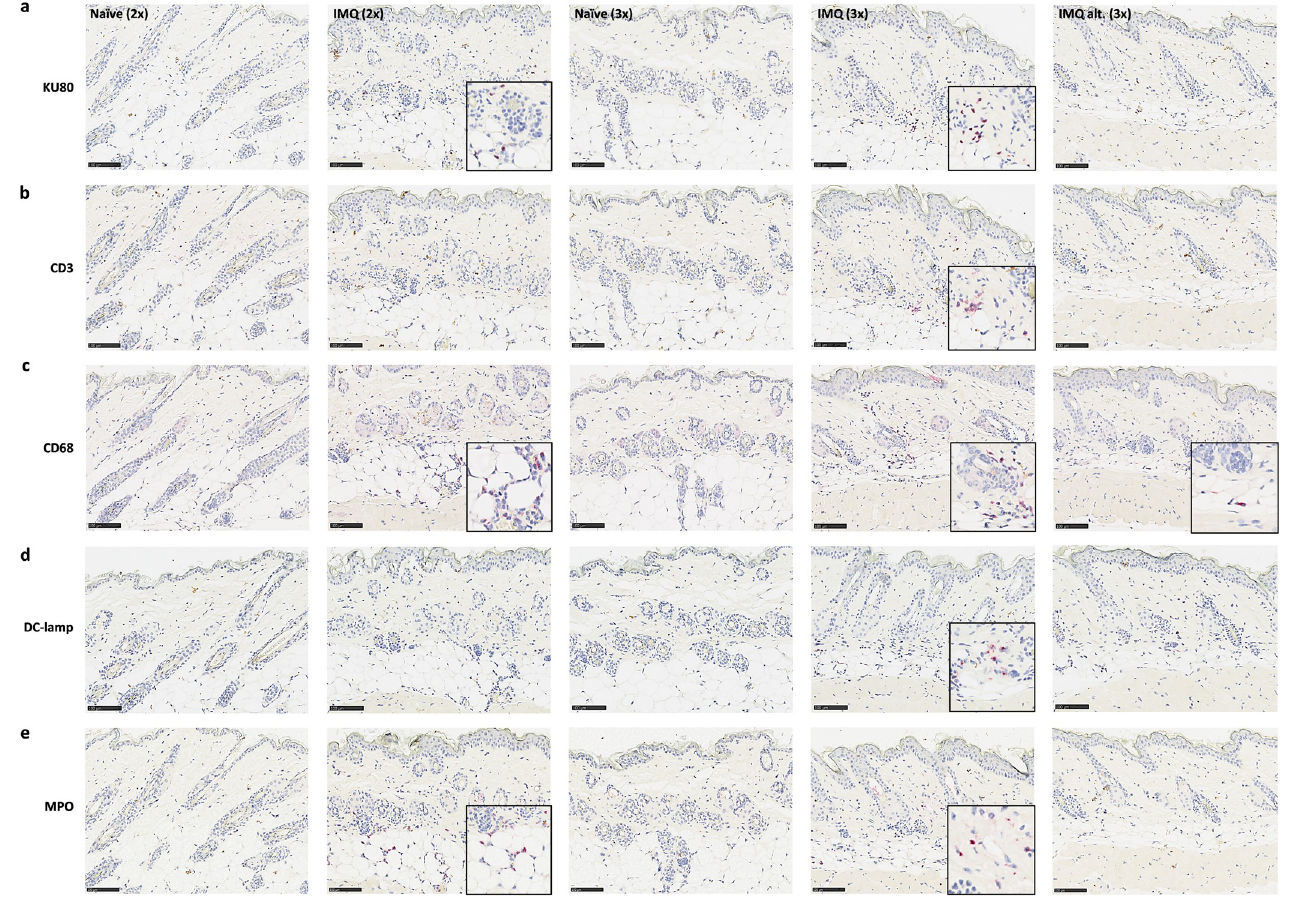
Fig 4. Immunohistochemical stainings to evaluate the presence of human and murine immune cells in the skin. IHC stainings of skin with (a) anti-KU80, (b) anti-CD3, (c) anti-CD68, (d) anti-DC-lamp, (e) anti-MPO. Representative slides are shown. The bar equals 100 μ m. A higher magnification of areas with positive staining has been included in slides with positive cells. In slides with no positive staining higher magnifications have not been shown.